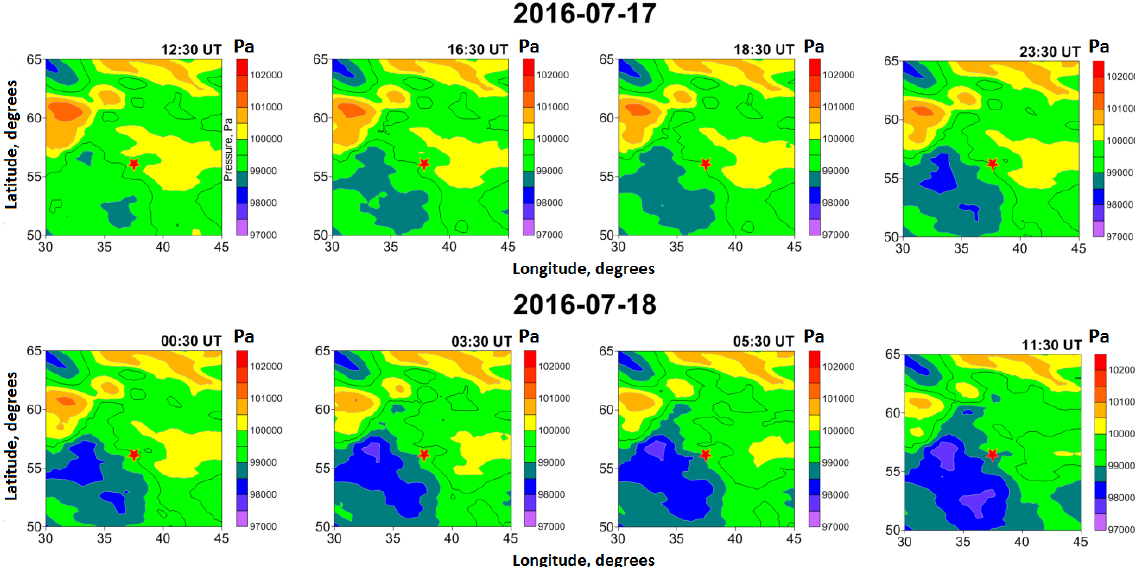
Figure 3. Observation data of surface pressure on 18 July 2016, available in the MERRA-2 database (https://disc.gsfc.nasa.gov/, last access: 1 August